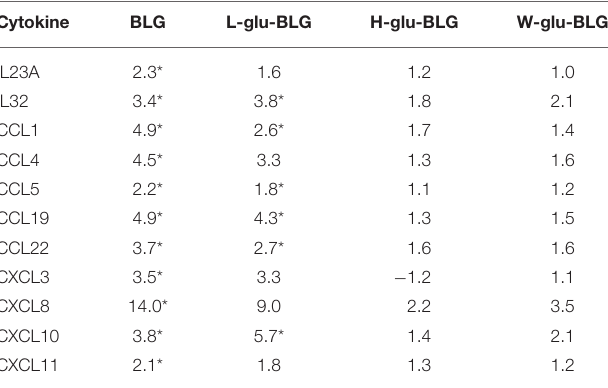
The values indicate fold changes of the transcription of THP-1 derived M0 exposed to different BLG samples compared to their control (exposed to culture medium) of N = 3 experiments, * q < 0.05.